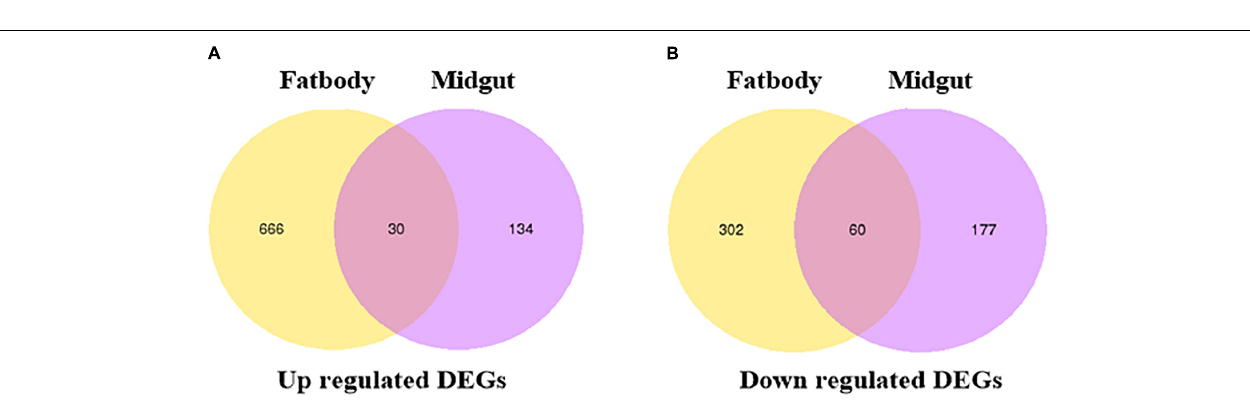
TOM in undamaged tomatoes were 0.61 ± 0.15 mg/g,